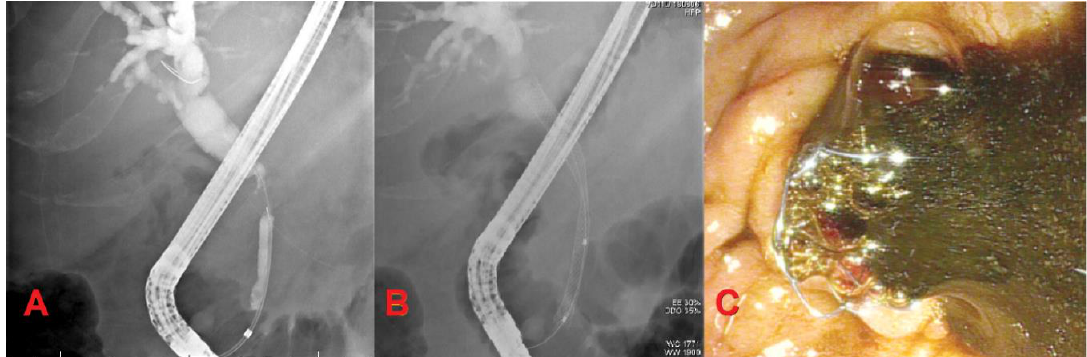
Figure 1. Extrahepatic cholangiocarcinoma. ( A ) Mid-common bile duct stricture with dilation of proximal bile duct and intrahepatics; ( B ) Fully-covered self-expandable metallic stent (FCSEMS) placement for biliary drainage; ( C ) Bile drainage after FCSEMS placement.